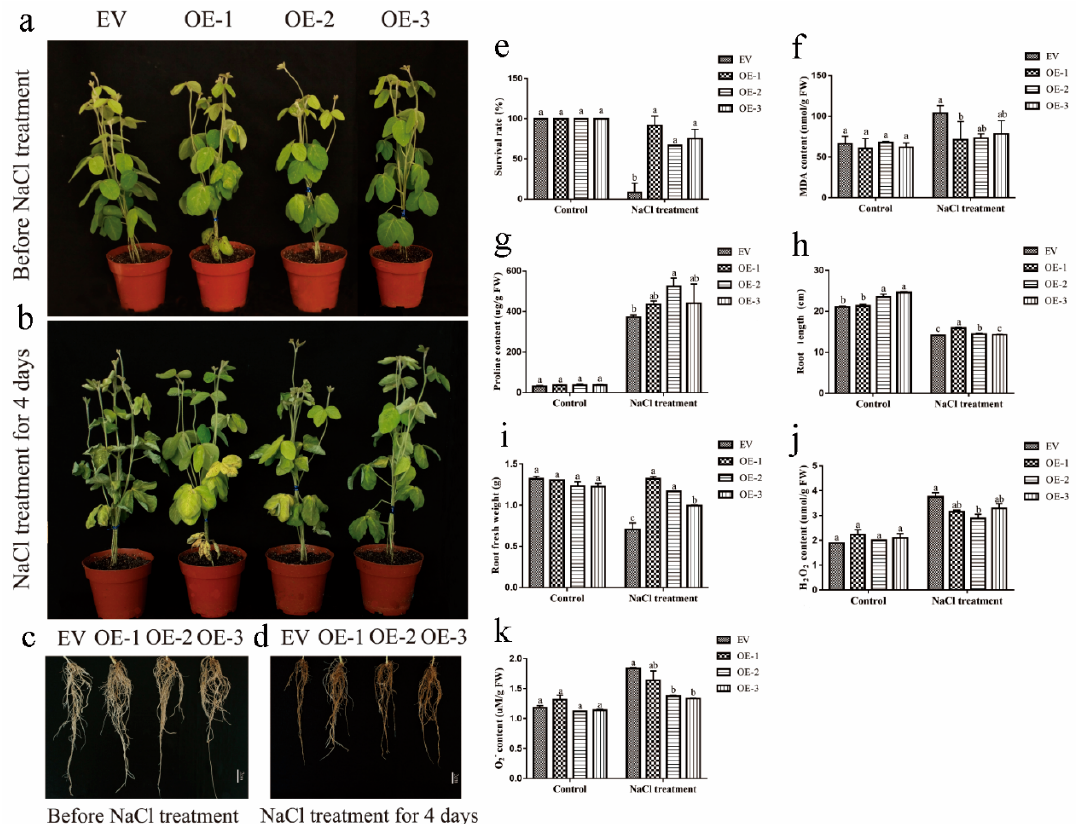
Figure 7. Phenotypic analysis of GmEF4 -overexpressing ( GmEF4 -OE) and EV-control plants under salt treatment. ( a ) and ( b ) Phenotypes of GmEF4 -OE and EV-control transgenic soybean plants under normal and salt treatment. ( c ) and ( d ) Phenotypes of GmEF4 -OE and EV-control hairy roots under normal and salt treatment. ( e ) Survival of normal and salt-stressed plants. ( f ) MDA content and ( g ) proline content of GmEF4 -OE and EV-control plants grown with salt treatment. ( h ) the root length, ( i ) total fresh weight, ( j ) H 2 O 2 content, and ( k ) O 2 − content of GmEF4 -OE and EV-control soybean hairy roots grown with salt treatment. The di ff erent letters in the bar graphs indicate significant di ff erences at p < 0.05 between GmEF4 -OE and EV-control transgenic soybean. 2.10. Overexpression of GmEF4 Reduced the Content of H 2 O 2 under Drought and Salt Stresses